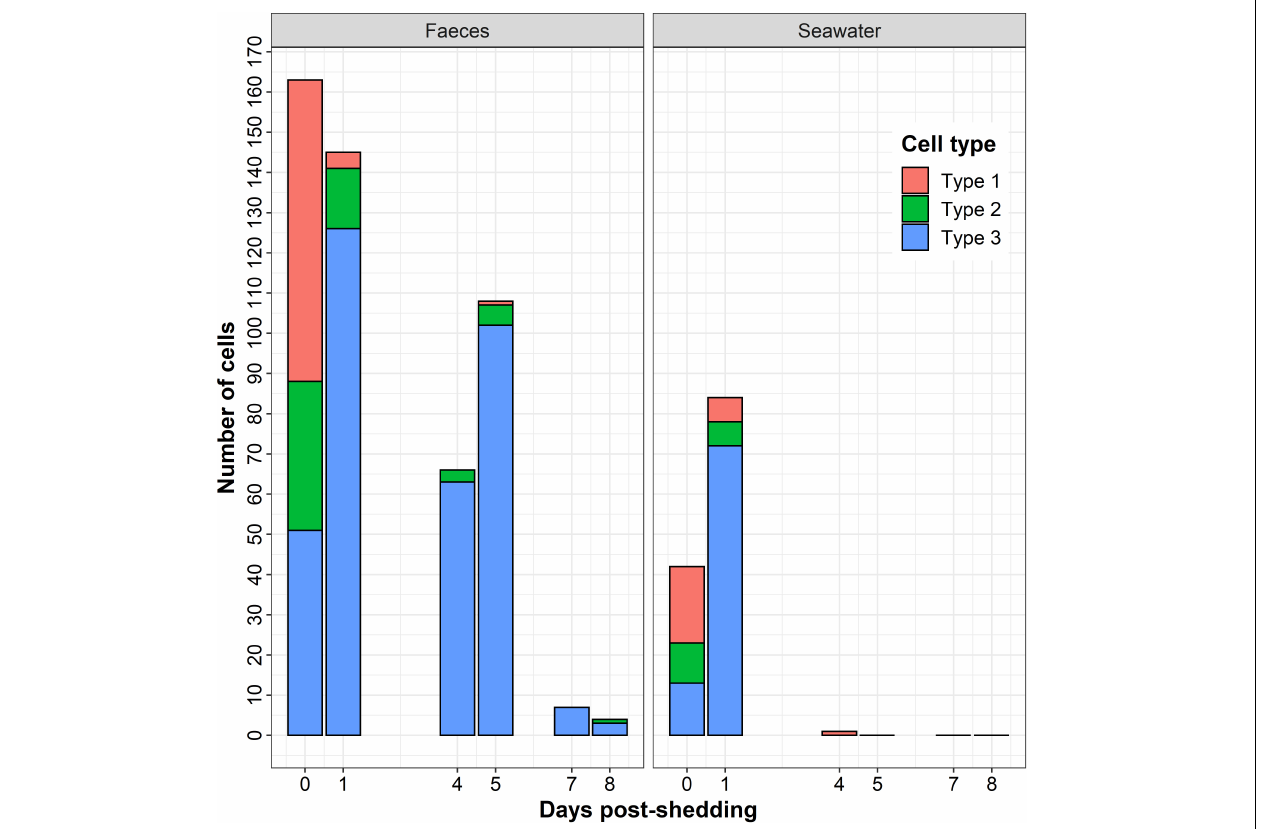
FIGURE 4 | Number of Marteilia refringens cell-types (Type-1: cell with visible membrane containing spores and refringent bodies, Type-2: cell with less visible membrane than in type 1 containing spores and refringent bodies, Type 3: cell without visible membrane containing spores and refringent bodies) observed per day by light microscopy on seawater and faeces cytocentrifugations (Hémacolor R (cid:13) stained). TABLE 1 | Measurements of Marteilia refringens sporangia and cell components observed by electron transmission microscopy.